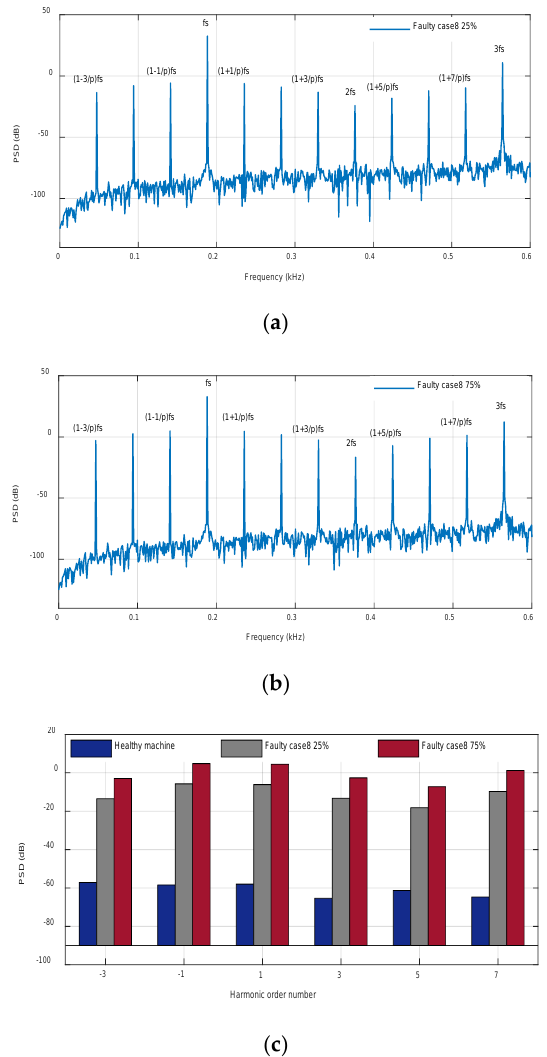
Figure 30. Faulty case 8: ( a ) PMSM current spectra normalized plot under 25%; ( b ) PMSM current spectra normalized plot under 75%; ( c ) ASBCs harmonics variations.